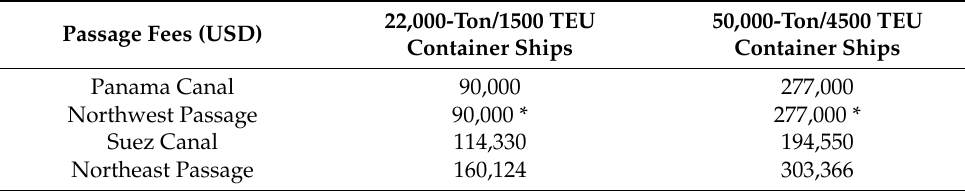
Table 5. Tolls and transit fees along different sea